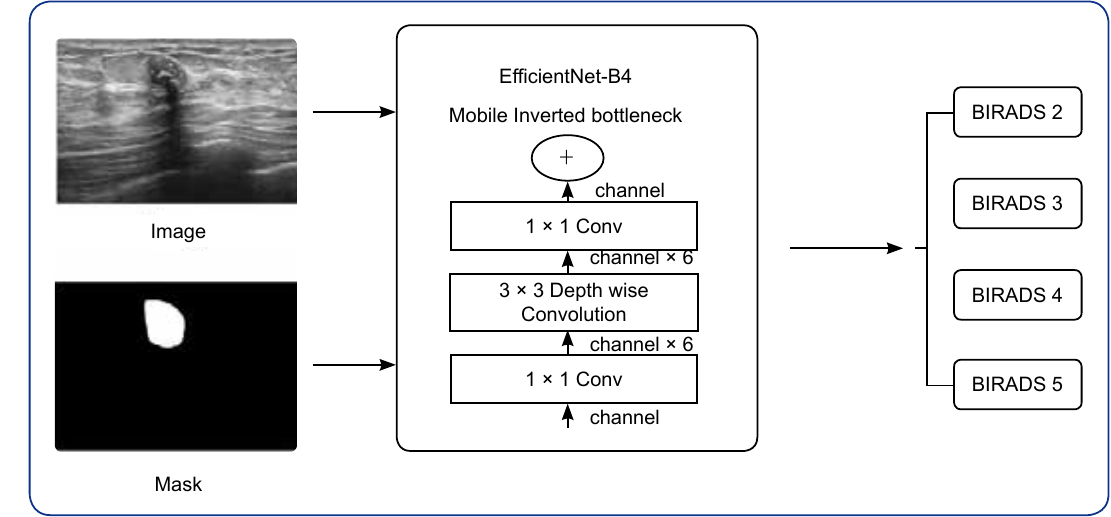
Figure 1 Schematic diagram of deep learning framework DE